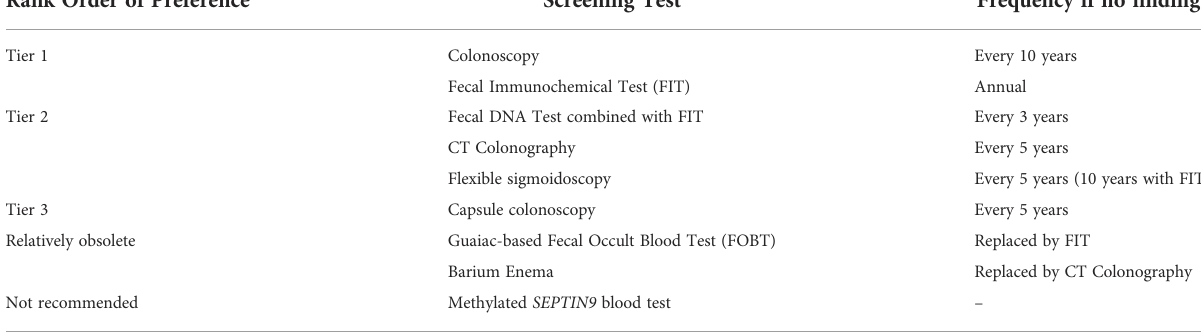
TABLE 1 Currently available, FDA-approved tests for colorectal cancer screening